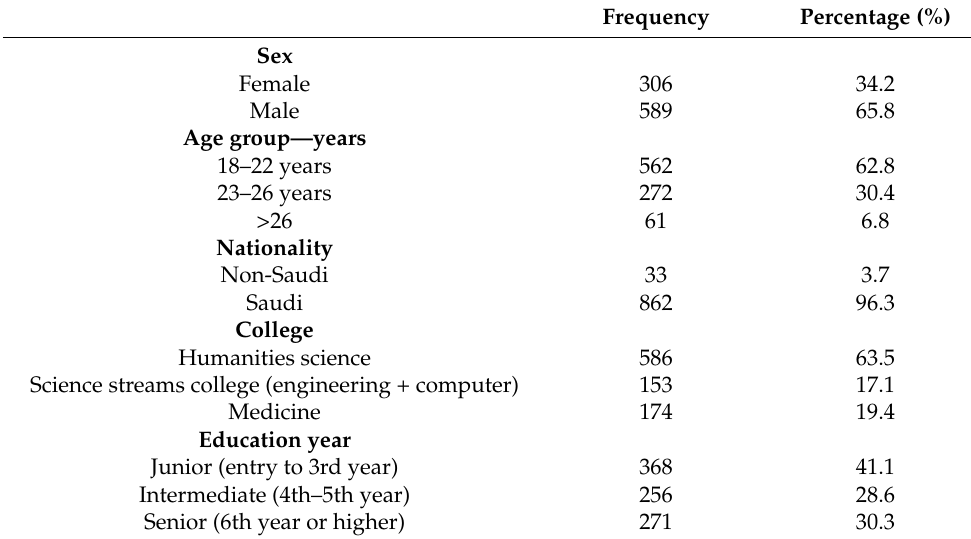
Table 1. Descriptive characteristics of university students. N =